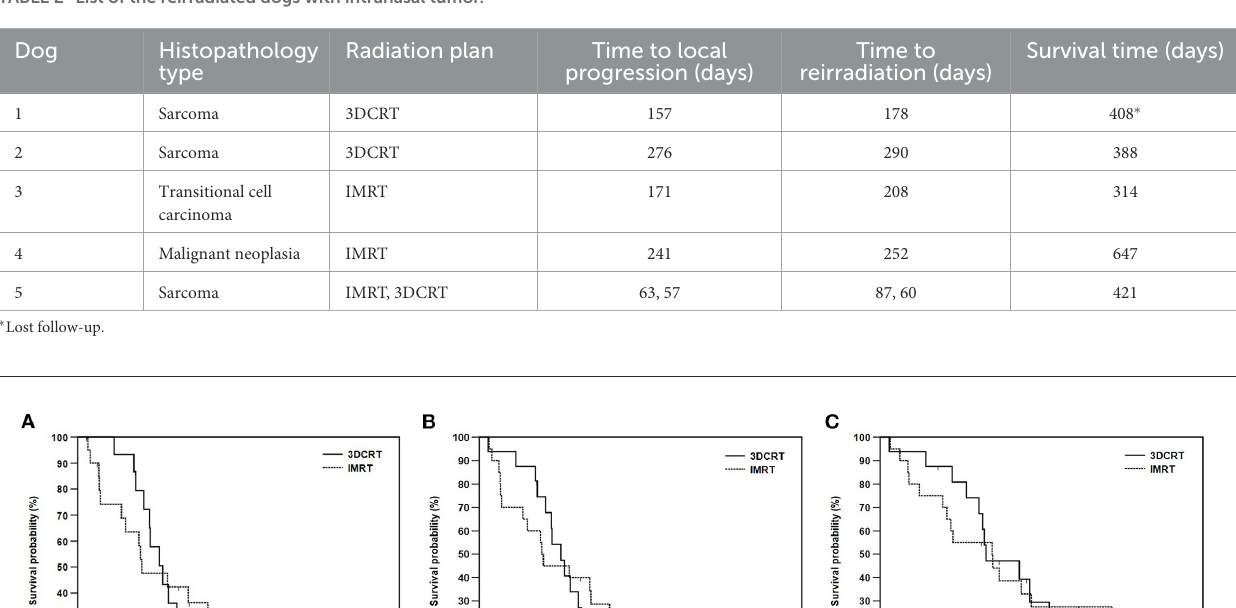
TABLE 2 List of the reirradiated dogs with intranasal tumor.